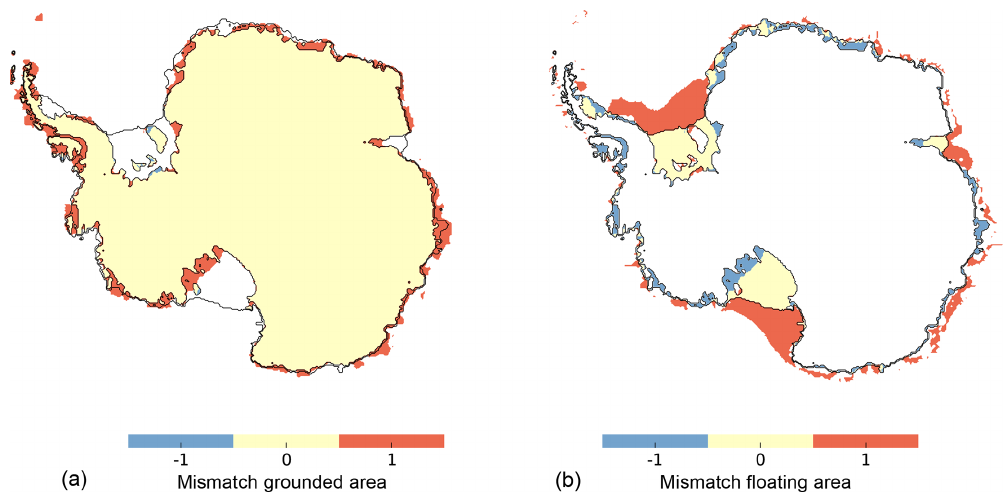
Figure 13. Comparison of present-day grounded (a) and floating (b) ice extent in best-fit ensemble simulation with respect to observations (Fretwell et al., 2013). Yellow indicates a match of simulation and observations, orange means grounded and floating in model but not in observations, and blue indicates the opposite. Root-mean-square distance of modeled and observed grounding line is 67km.